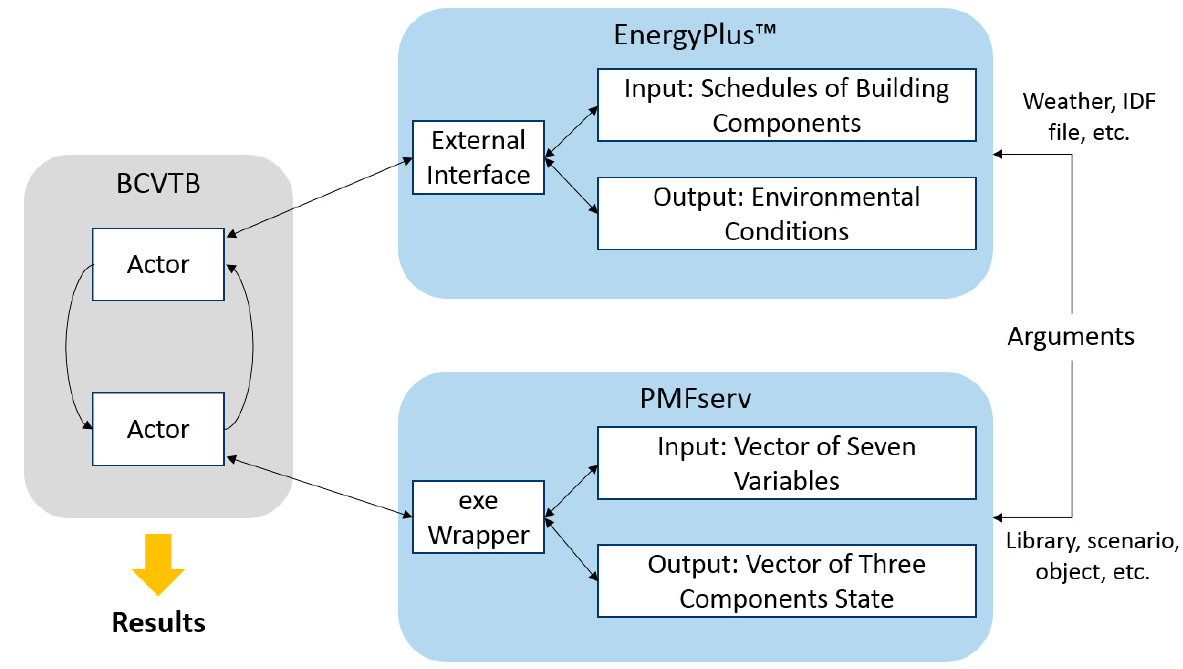
Figure 2. co-simulation framework development in a conceptual view. Figure 2. Co–simulation framework development in a conceptual view.